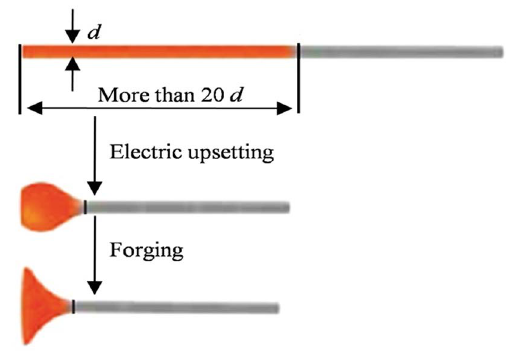
Figure 1: Forming steps for an engine valve.